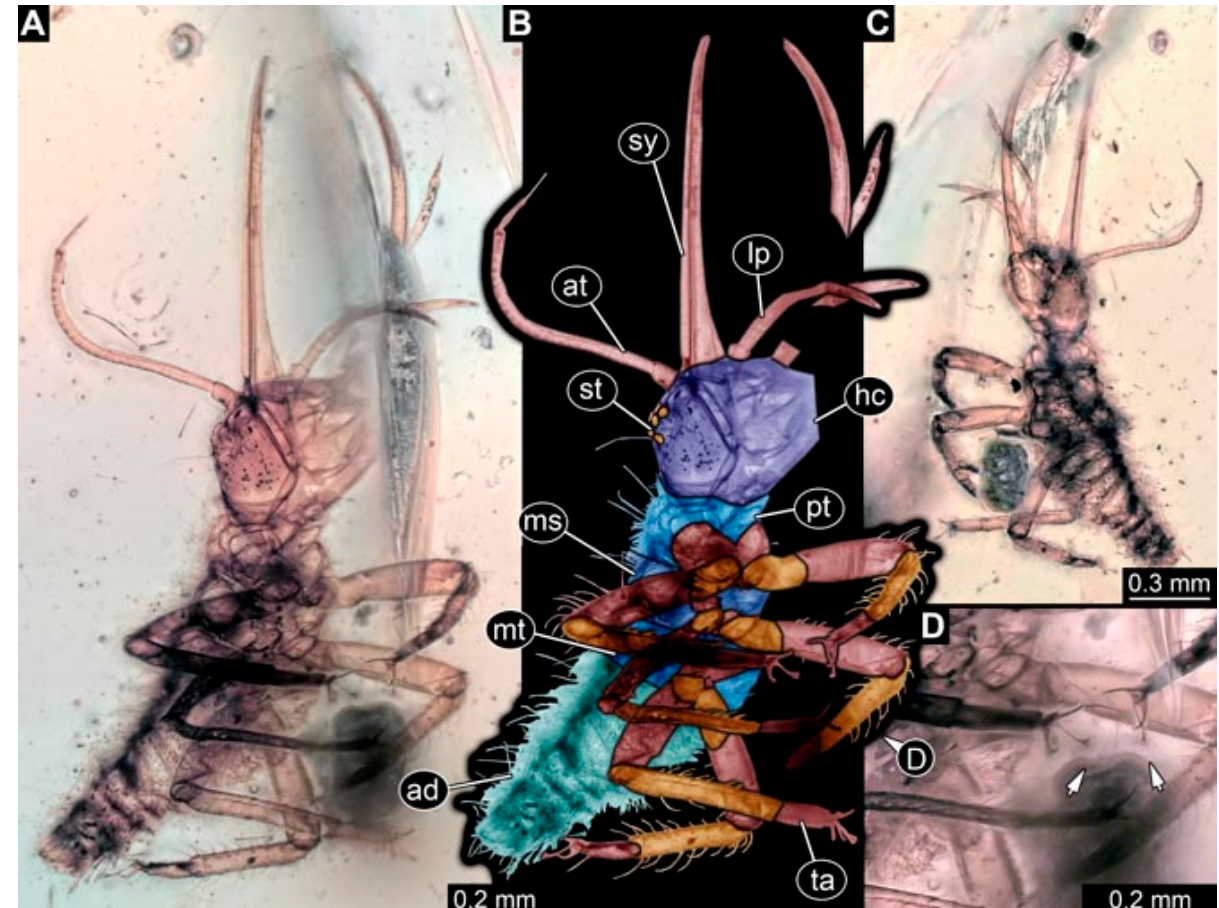
Figure 41. Specimen 4870 (PED 1301); Myanmar amber. ( A ) Ventral view. ( B ) Ventral view, colour- marked. ( C ) Dorso-lateral view. ( D ) Close-up of trunk appendages with empodia (arrows). Abbre- viations: ad = abdomen; at = antenna; hc = head capsule; lp = labial palp; ms = mesothorax; mt = metathorax; pt = prothorax; st = stemmata; sy = stylet; ta = tarsus.